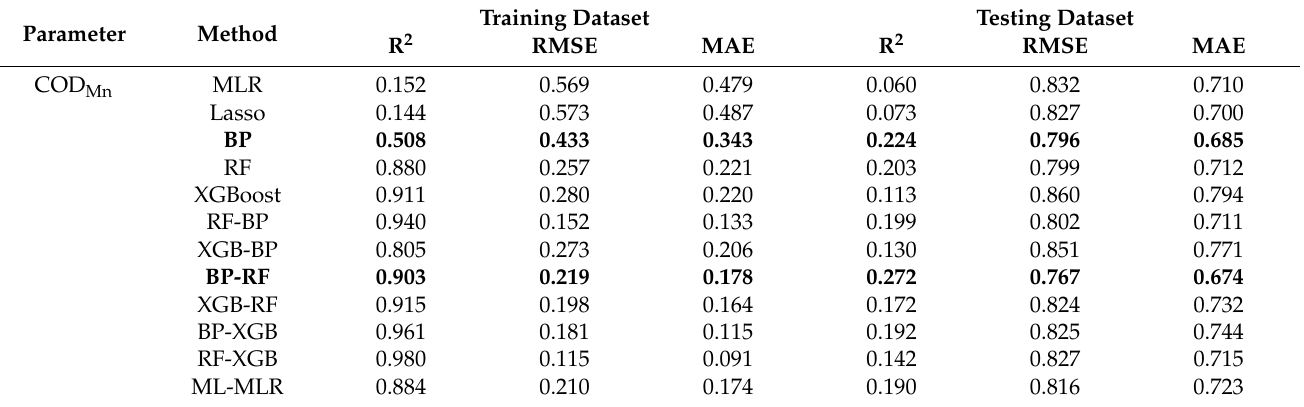
Table 10. Comparison of the performance of single ML models and stacked ML models for COD Mn .